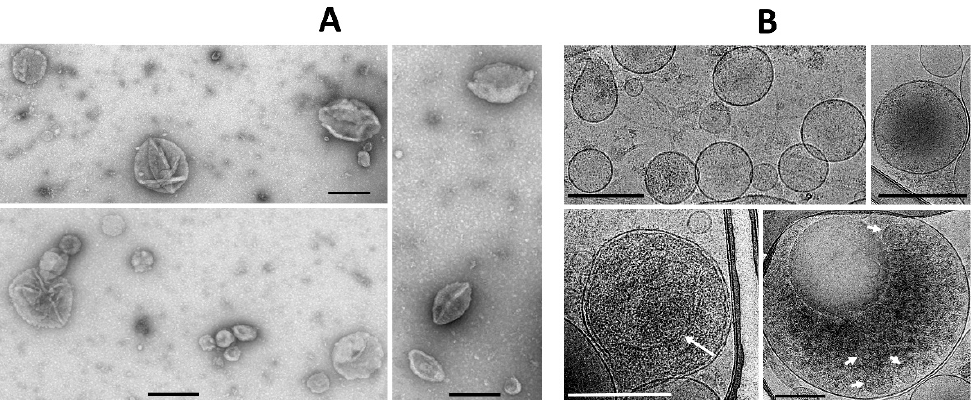
Figure 2. Examples of different configurations of ectosomes obtained by conventional ( A ) and cryo ( B ) electron microscopy after centrifugation of the MSC culture medium at 10,000 × g . Note the heterogeneity of sizes with average around 250 nm, the frequent presence of shell-like profiles in ( A ), and the presence of membrane-like structures in the EV lumen in all images in A and in a simple image in ( B ) shown by a long arrow. Short arrows in ( B ) demonstrate the presence of vesicles within a multivesicular body. Bar, 250 nm in ( A ) and 300 nm in ( B ).